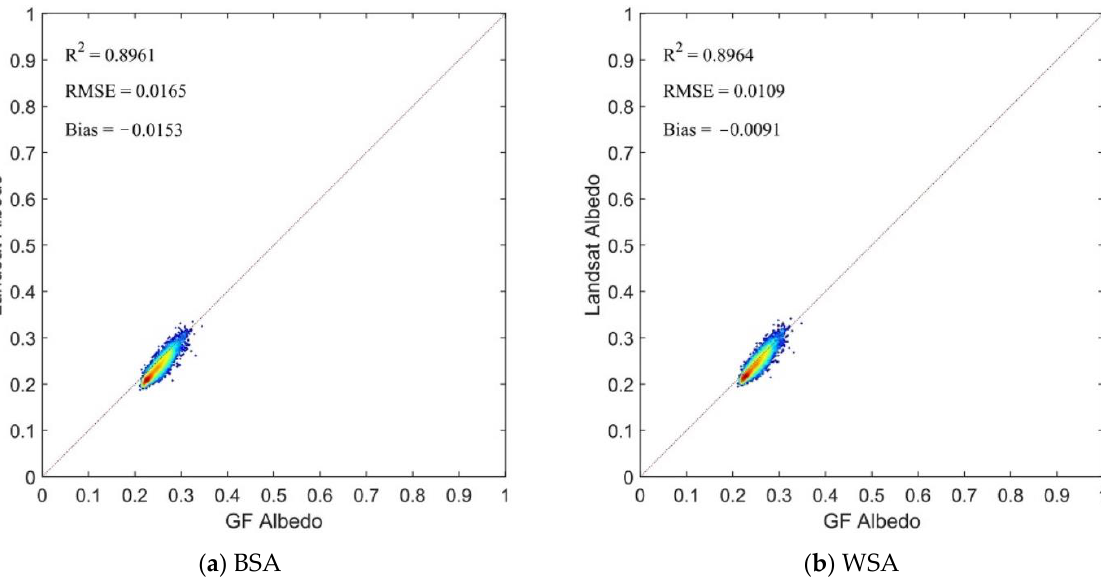
Figure 7. Scatter plot of albedo comparison between GF-1 WFV and Landsat-8.